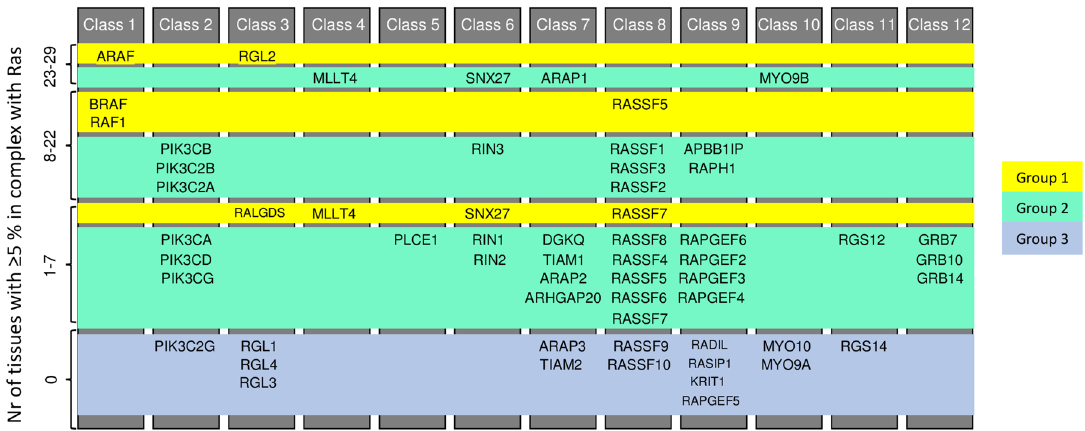
Fig. 8 Key effectors for Ras signaling. Contribution of each of the 56 effectors to Ras binding was analyzed according to a 5%-complex- formation threshold, both for the unstimulated and the stimulated Ras network. Each effector forming a complex for at least 5%, in the unstimulated case, was classi fi ed in Group 1; if this happened in the stimulated case (according to the results from global sensitivity), it entered Group 2; otherwise it fed into the last group. – Group 1: ef fi cient Ras-effector complex formation with RBD. Group 2: ef fi cient Ras- effector complex formation with RBD and additional domains recruited to the plasma membrane. Group 3: inef fi cient Ras-effector complex